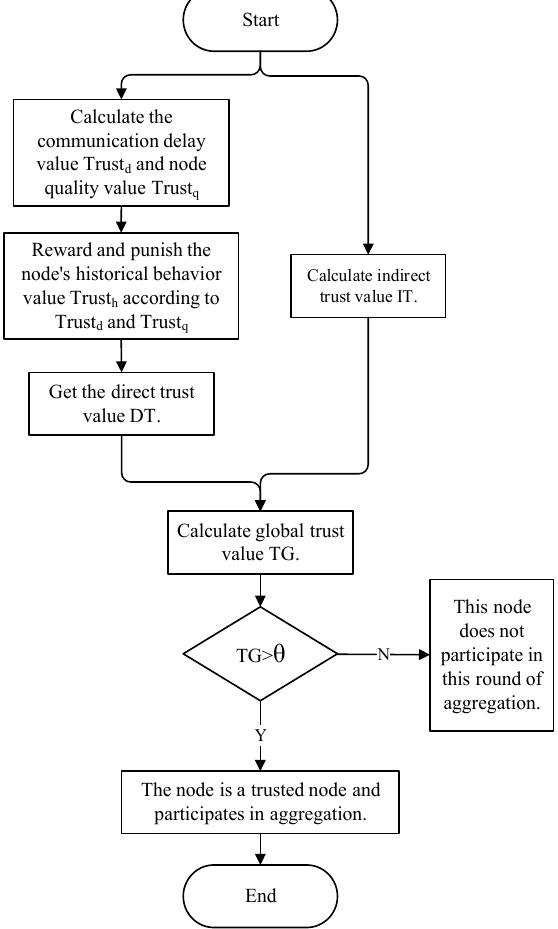
Figure 5. Flow chart of node selection mechanism based on trust. This mechanism divides the global trust value into direct and indirect trust.